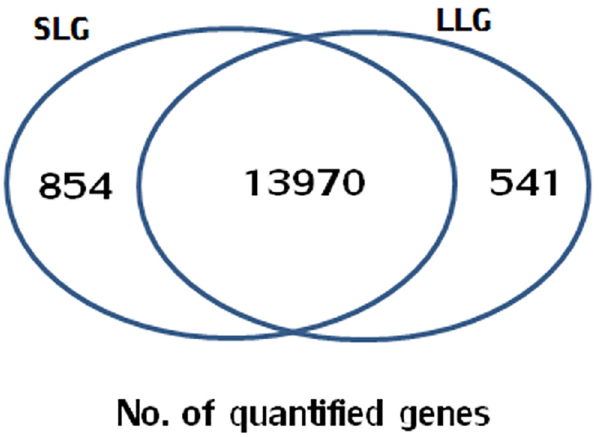
Fig 1. Identification of DEGs by RNA-Seq analysis. The number of annotated genes using RNA-seq is shown. A total of 14,511 genes in the LLG and 14,824 genes in the SLG were detected. The number of commonly expressed genes among both groups was